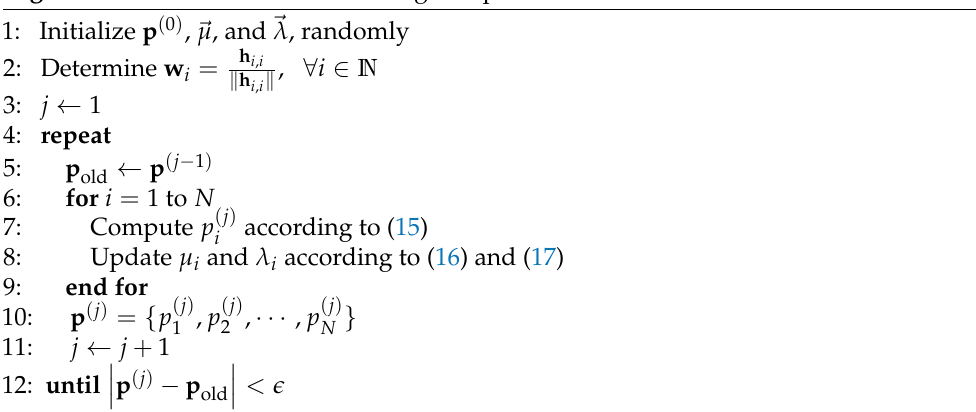
Algorithm 1 Distributed beamforming and power